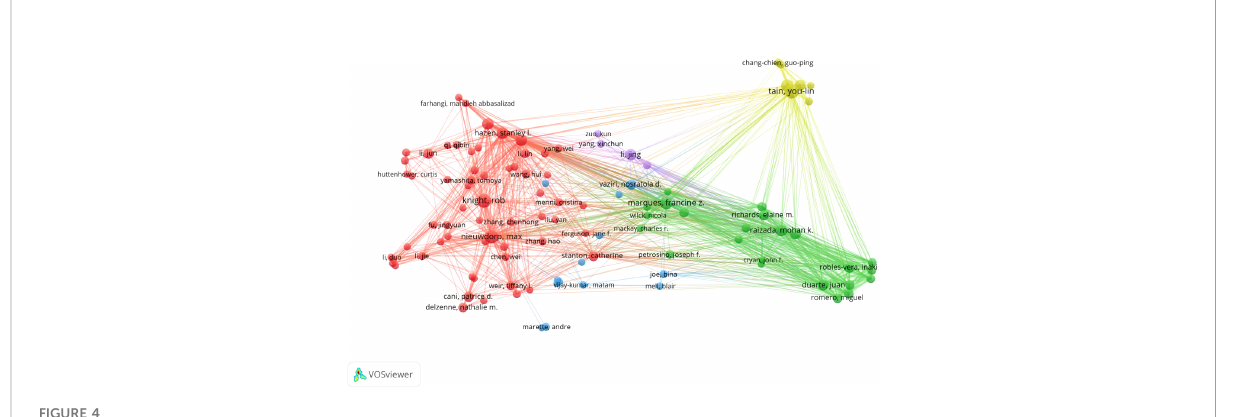
FIGURE 4 Visualization map of 103 authors with more than fi ve